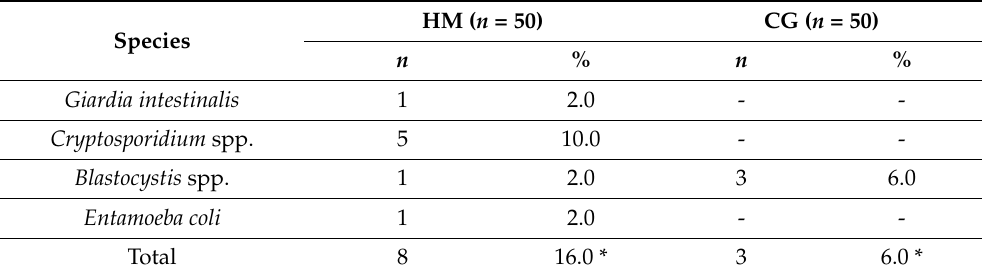
Table 1. Prevalence of intestinal parasites in immunosuppressed patients with hematological malig- nancies (HMs) and immunocompetent participants (CG) (-, not detected). HM ( n = 50) CG ( n = 50) Species n % n % Giardia intestinalis 1 2.0 - - Cryptosporidium spp. 5 10.0 - - Blastocystis spp. 1 2.0 3 6.0 Entamoeba coli 1 Total